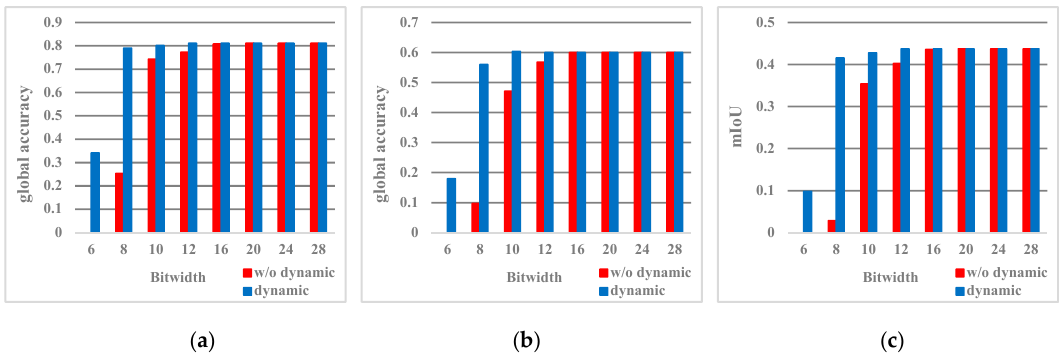
ff erent quantization strategy. ( a ) global accuracy; ( b ) class accuracy; ( c ) Figure 7. Accuracy with different quantization strategy. (a) global accuracy; (b) class accuracy; (c) mIoU. Figure 7. Accuracy with di